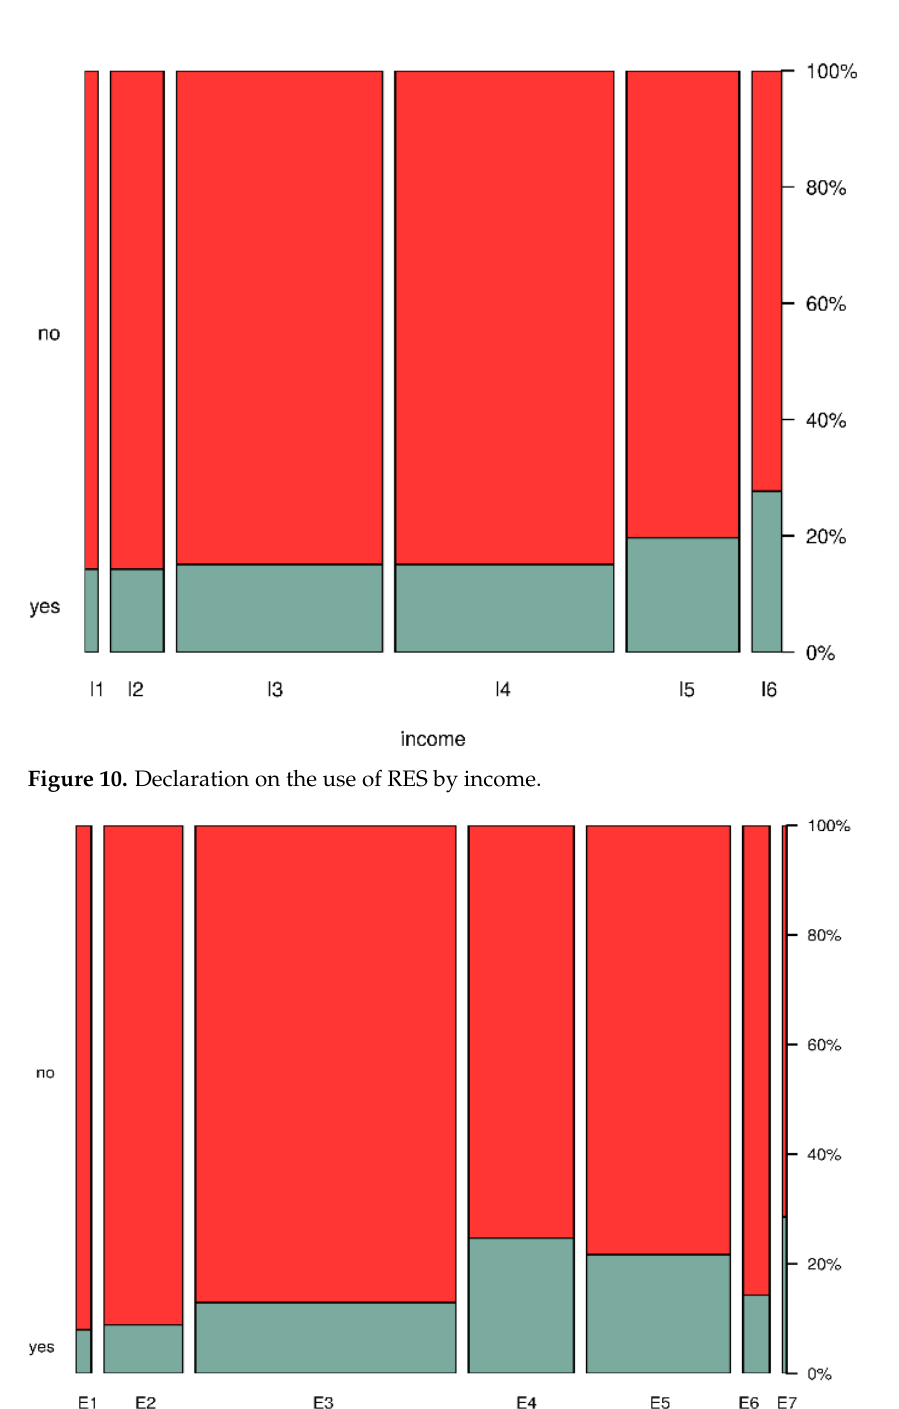
Figure 11. Declaration on the use of RES by education level.